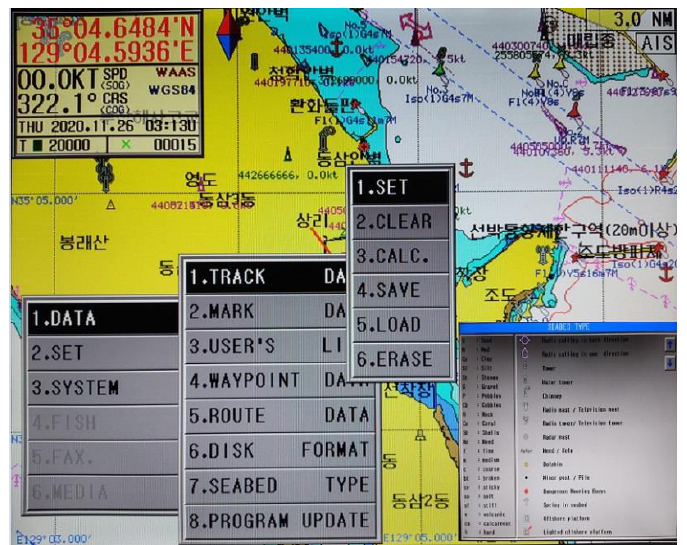
Figure 1. Standard display of model